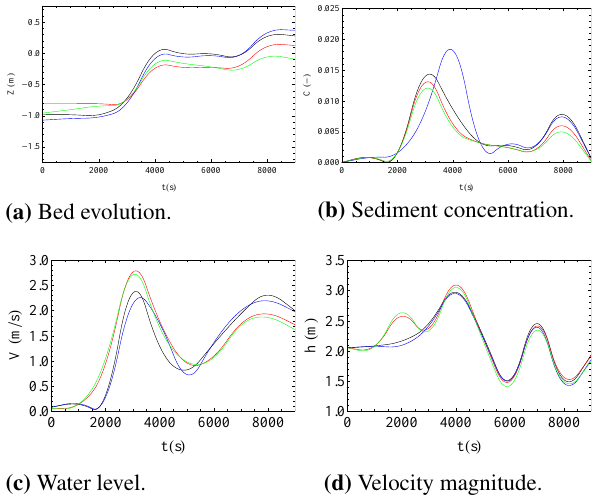
(c) Water level. (d) Velocity magnitude.